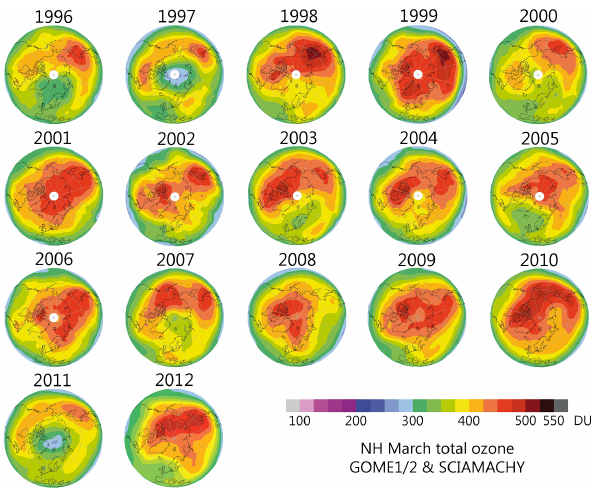
Fig. 1. Polar stereographic maps of mean Arctic total ozone in March as obtained from the GSG data set, containing observa-